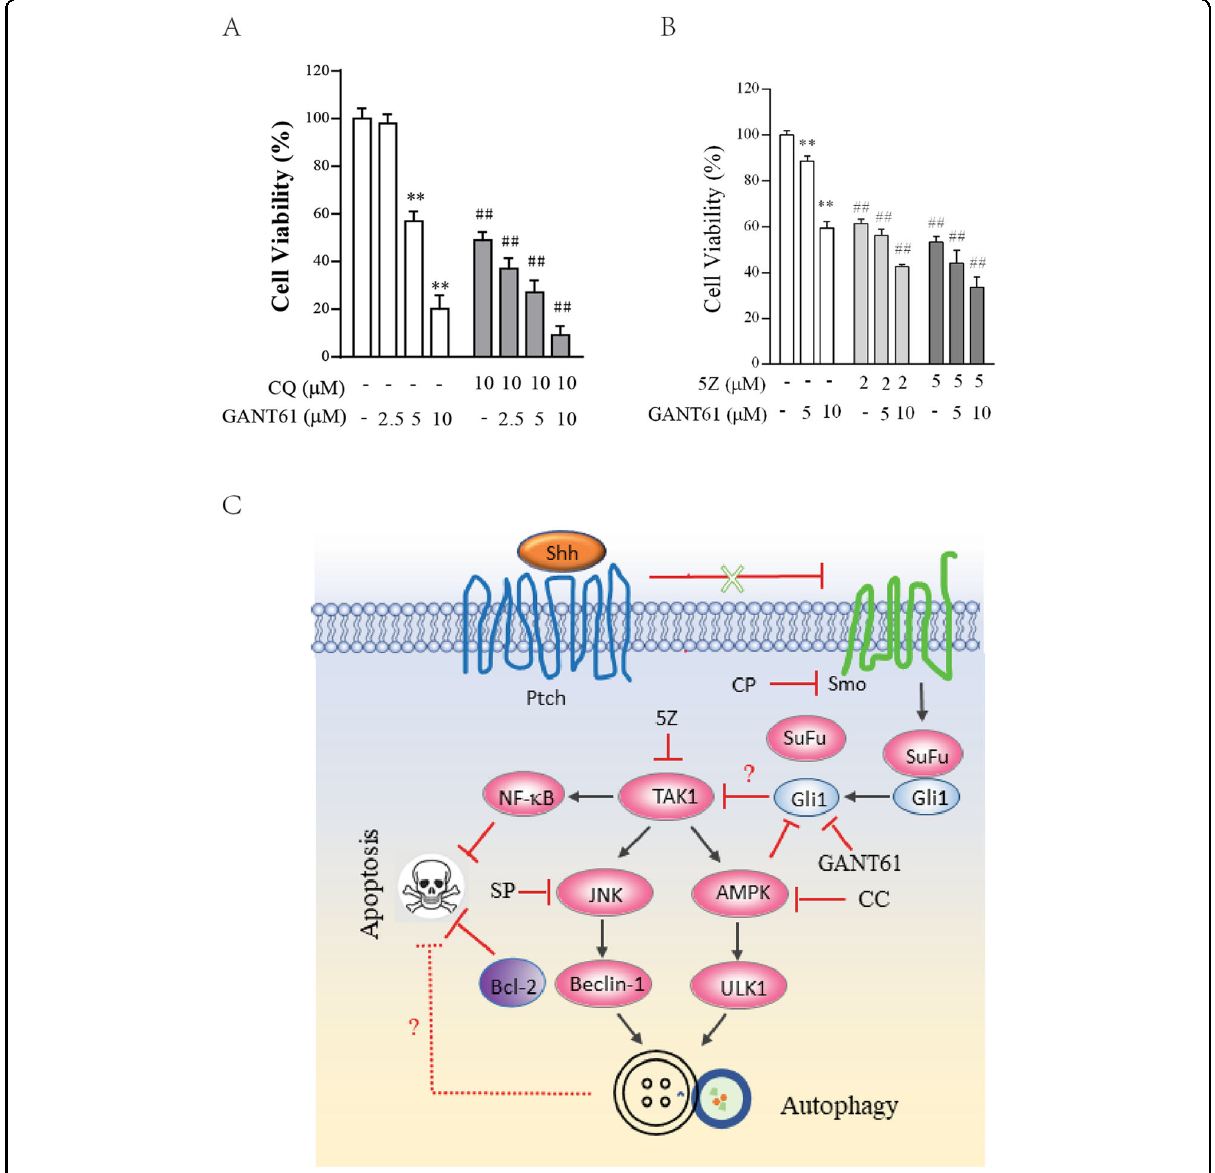
Fig. 6 Inhibition of autophagy potentiates the antiproliferative effect of GANT61. SW1736 cells seeded in 96-well plates (2000 cells/well) were incubated with the indicated concentrations of GANT61 minus or plus CQ (10 μ M) ( A ) for 72 h or 5Z (2 or 5 μ M) ( B ) for 48 h. Cell viability was measured by using a CellTiter-Glo kit. Data are the mean ± SD of the triplicate from one representative of three independent experiments with similar results. **p < 0.01, compared to the untreated control; ## p < 0.01, compared to the counterparts in SW1736 left untreated or treated with the same concentrations of GANT61. C The mechanisms of Shh pathway inhibition-induced autophagy. Shh binding to Ptch releases the restriction of Smo activity. Activated Smo disrupts the interaction between Sufu and Gli1. Inhibition of the Shh pathway by the Smo inhibitor cyclopamine or by the Gli1 inhibitor GANT61 activates TAK1, which then activates JNK and AMPK. JNK promotes autophagy by phosphorylating Bcl-2 and dissociating it from Beclin-1. Free Beclin-1 becomes available for the initiation of autophagy. AMPK phosphorylates ULK1 and activates it. ULK1 is involved in the assembly of the pre-initiation complex and the early formation of autophagosomes. Activation of the autophagic pathway by inhibition of the Shh pathway attenuates apoptosis by multiple pathways including the activation of NF-kB and JNK by TAK1. Autophagy itself appears to also suppress apoptosis, albeit its underlying mechanism remains unknown. In addition, it is also not clear how Gli1 suppression leads to TAK1